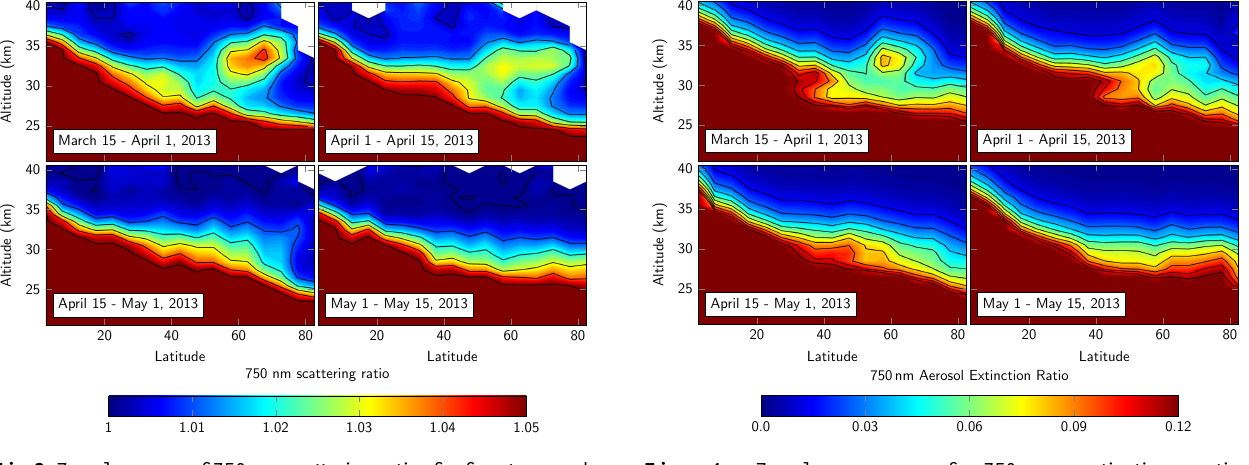
Fig. 3. Zonal average of 750nm scattering ratios for four two-week time periods starting approximately one month after the meteor im- pact. Contours mark every 1% increase over background scattering up to 5%.